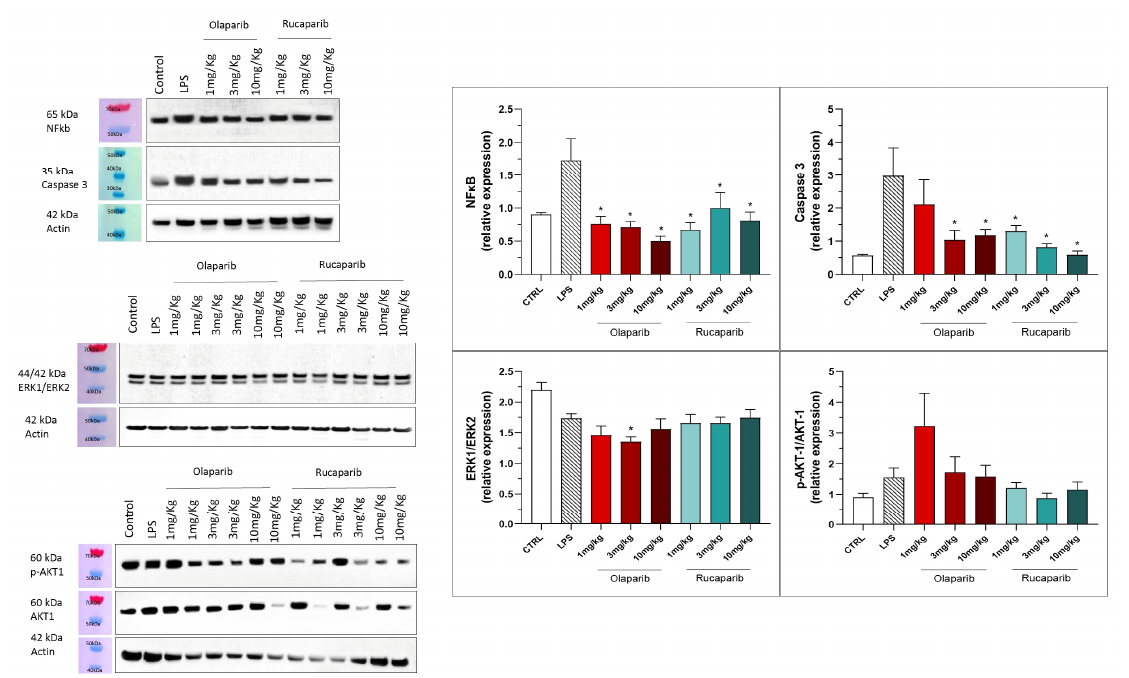
Figure 16. Effect of olaparib and rucaparib on NF- κ B, caspase 3, ERK2/ERK1 and pAKT/AKT levels in the lung tissue in a murine model of ALI. C57Bl/6 mice received either PBS (30 µ L) or LPS (50 µ g in 30 µ L PBS) by intratracheal instillation in the absence or presence of various doses (1, 3, or 10 mg/kg) of olaparib or rucaparib. After 24 h, lungs were collected, and NF- κ B (65 kDa) and caspase 3 levels, ERK1/ERK2 ratio, and pAKT/AKT ratio were measured by Western blotting. * p < 0.05 indicates an inhibitory effect of the PARP inhibitors tested in LPS-treated animals. Data are shown as mean ± SEM, n =